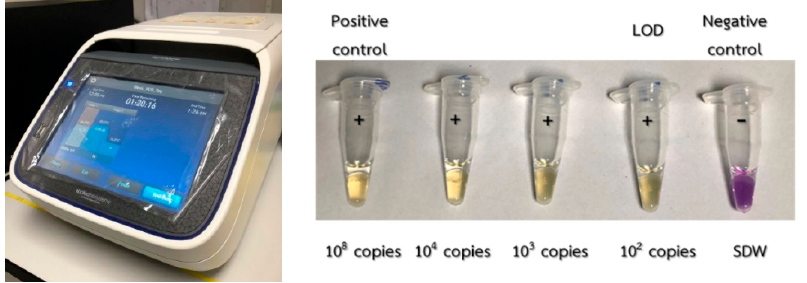
Figure 15. Sensitivity test results in thermal cyclers at a temperature of 64 °C for 75 min.